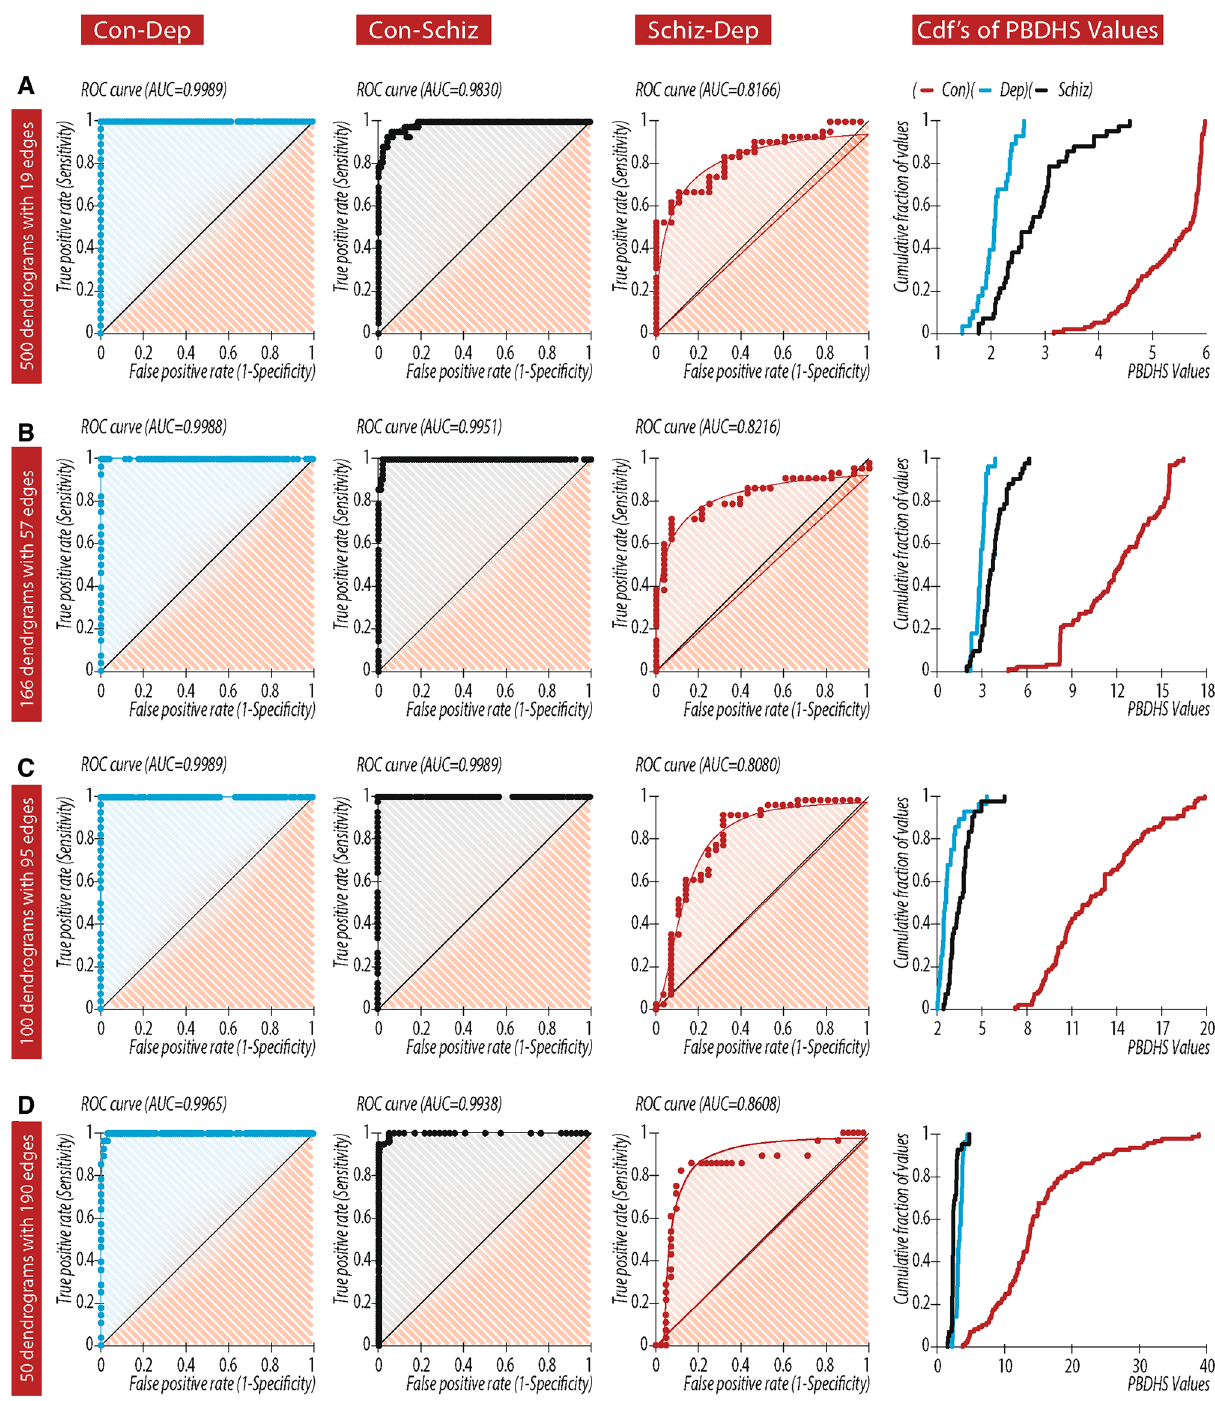
Figure 3. Accuracy of the EEG based personal block DH signatures (PUDHSs) in differentiating control, schizophrenia and depression patient groups. Accuracy depicted as receiver operating characteristic (ROC) curves for all pairs of clinical groups and CDFs of PBDHS values in each group. Each of the 500 s EEG recordings was separated into a time series of block dendrograms ( A ) 500 dendrogram of 19 edges each, ( B ) 166 dendrogram of 57, ( C ) 100 dendrograms of 95 edges. ( D ) 50 dendrograms of 190